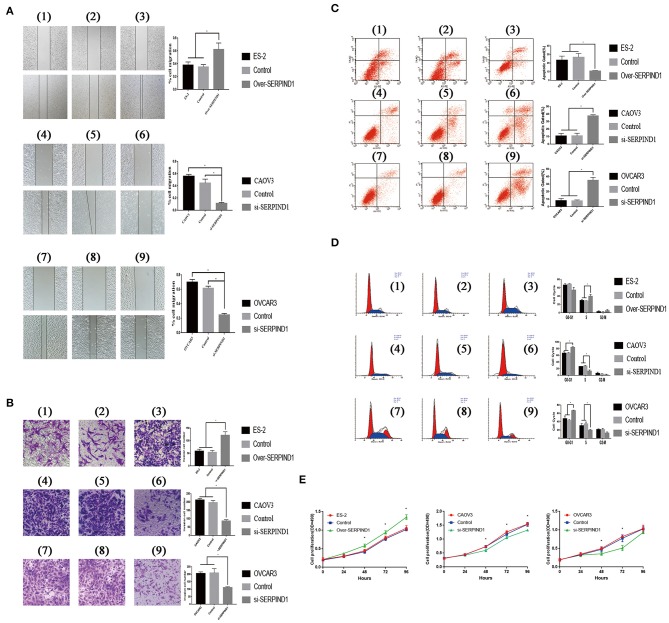
Effects of SERPIND1 on ovarian cancer cells in vitro. (A) SERPIND1 promoted the migration capacity of ovarian cancer cells. (B) SERPIND1 promoted the invasion capacity of ovarian cancer cells. (C) SERPIND1 inhibited apoptosis in ovarian cancer cell lines. (D) Effects of SERPIND1 on the cell cycle of ovarian cancer cell lines. (E) SERPIND1 promoted the proliferation of ovarian cancer cells. (1): ES-2; (2): ES-2-SERPIND1-H-Mock; (3): ES-2-SERPIND1-H; (4): CAOV3; (5): CAOV3-SERPIND1-L- Mock; (6): CAOV3-SERPIND1-L; (7): OVCAR3; (8): OVCAR3-SERPIND1-L- Mock (9): OVCAR3-SERPIND1-L. Data are presented as mean ± standard deviation from three independent experiments. *P < 0.05. Scale bar: 100 μm. SERPIND1, serpin family D member 1.